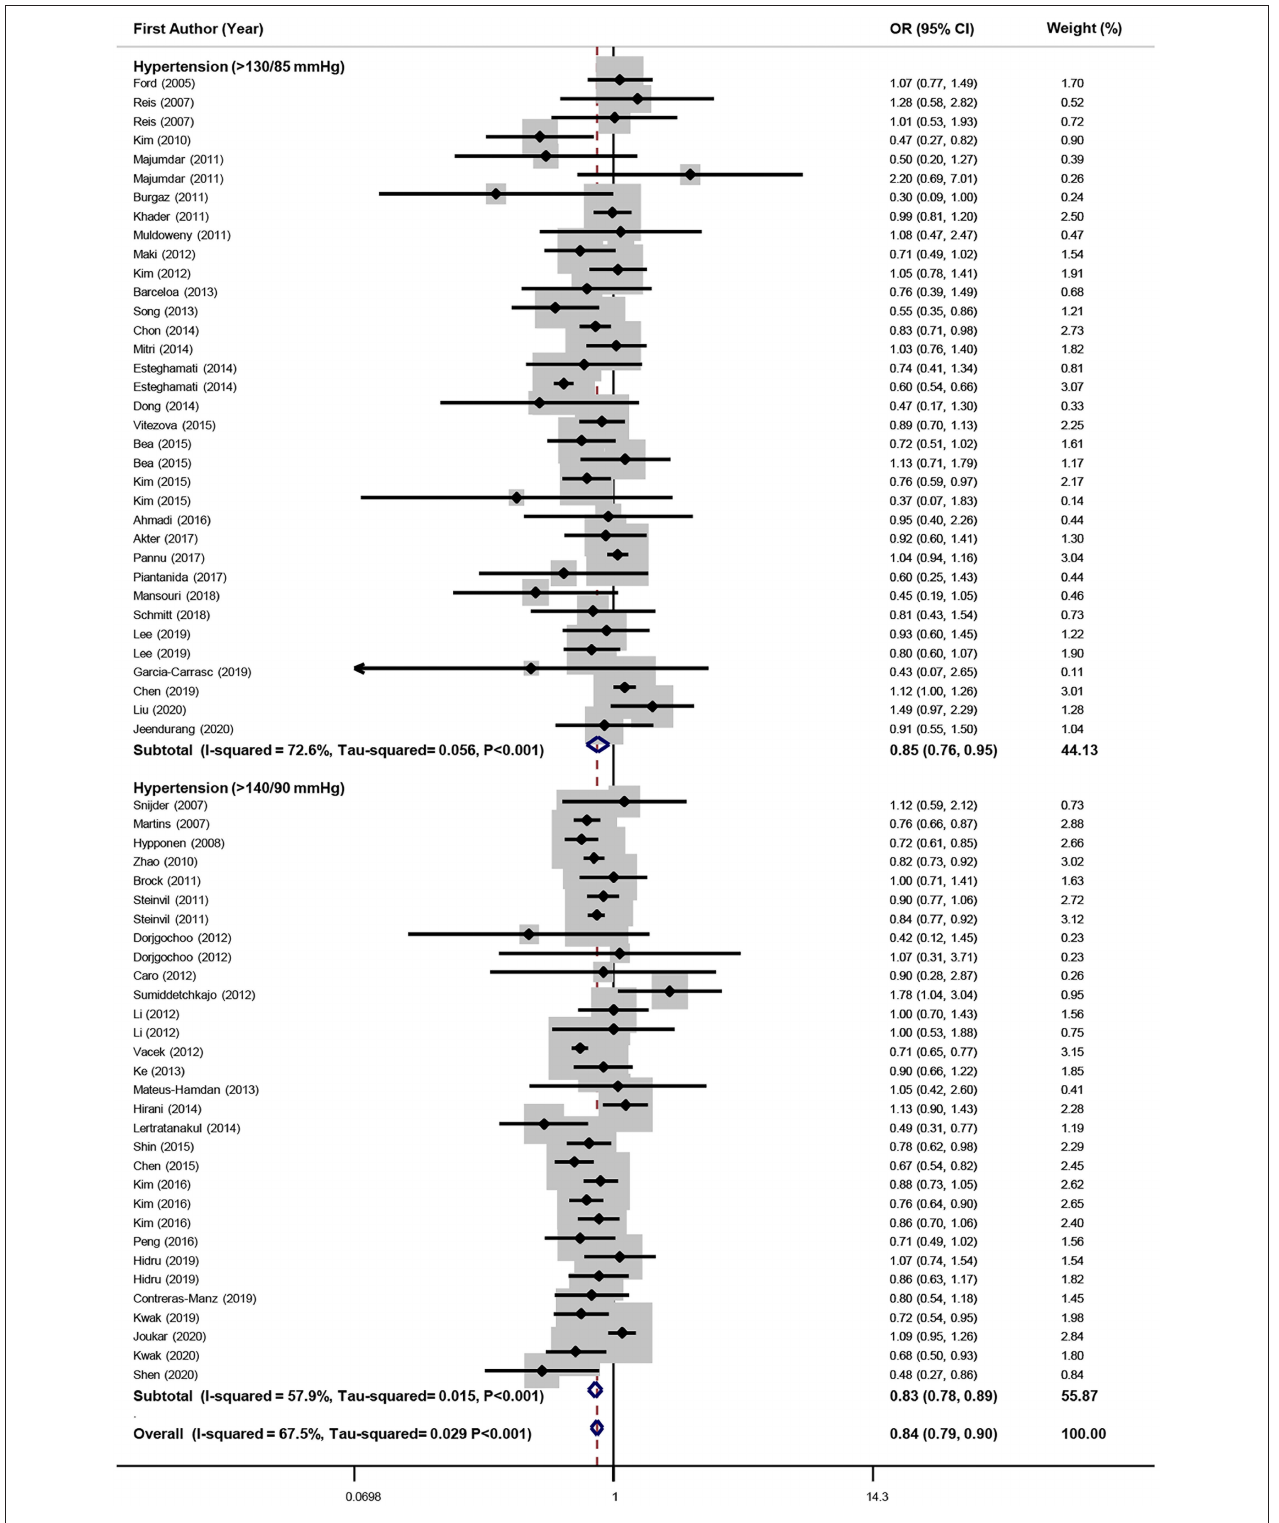
FIGURE 5 | Forest plot of cross-sectional studies that examined the association between highest vs. lowest level of serum vitamin D and odds of HTN.